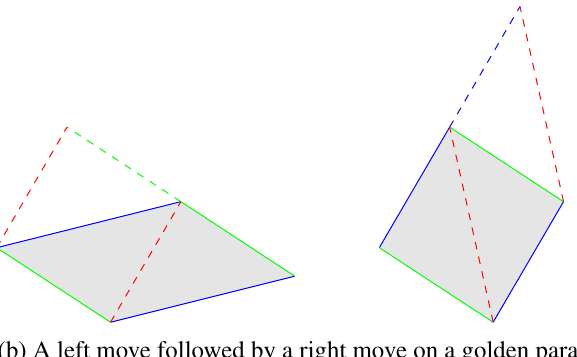
(b) A left move followed by a right move on a golden parallelogram. q . The sides ζ b The initial quadrilateral has blue right slanted and green left slanted (cid:96) and ζ tr are left slanted while ζ br and ζ t (cid:96) are right sides. The top-bottom diagonals are in red. The sides of the new slanted. quadrilateral are dashed. Figure 4: Quadrangulations and diagonal